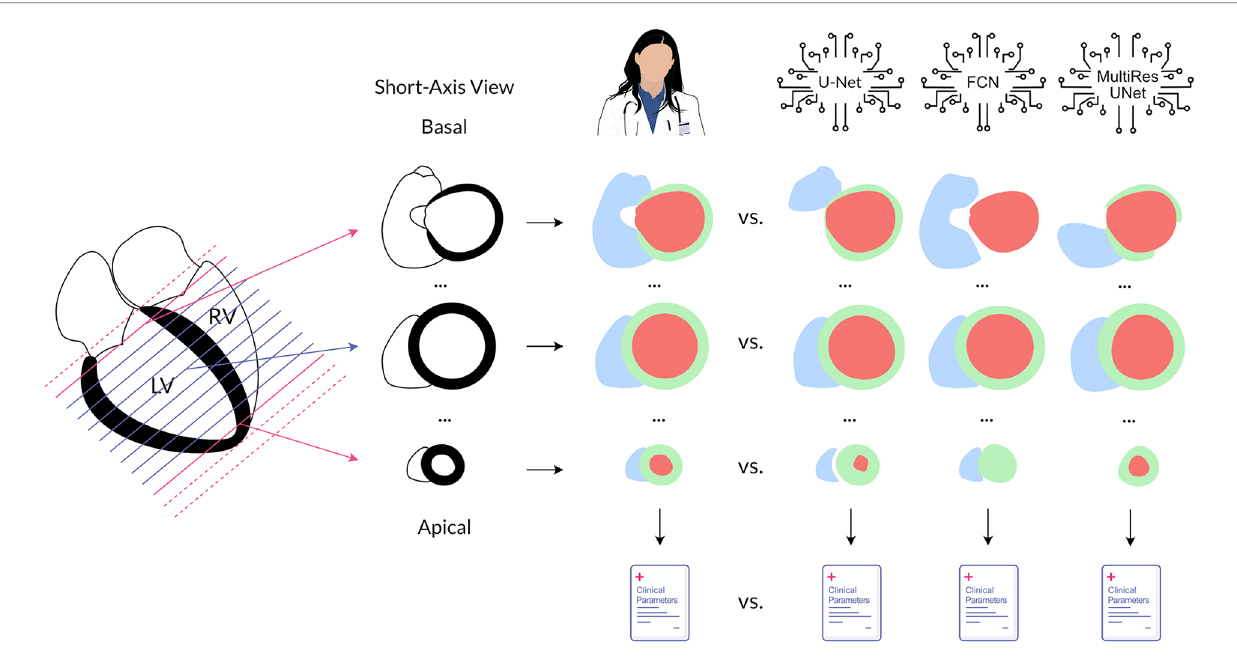
FIGURE 2 Method overview. Cardiovascular magnetic resonance cine images in the short axis were annotated by an experienced physician and three convolutional neural networks to quantify left and right ventricular function. The obtained segmentations and the clinical parameters calculated from them were compared for each neural network against the expert. In addition, analysis was performed separately by position in the heart. Legend: LV, left ventricle; RV, right ventricle; red, left ventricular cavity; green, left ventricular myocardium; blue, right ventricular